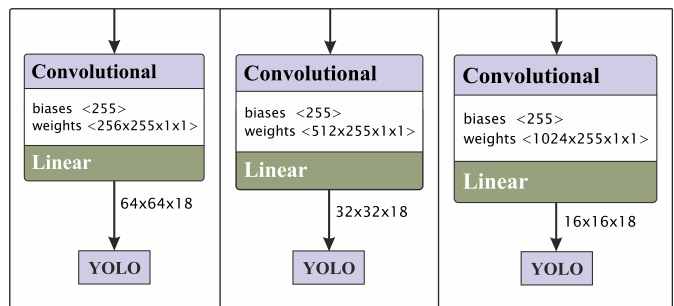
Figure 5. The YOLO-based heads applied at different